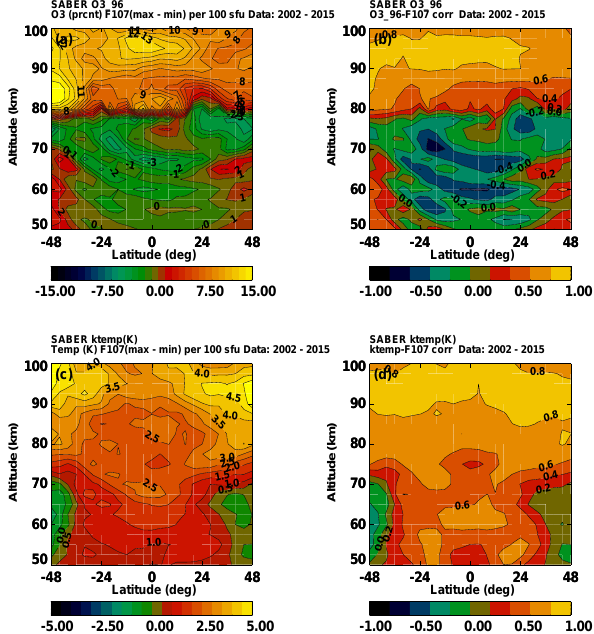
Figure 3. Ozone and temperature responses to solar variability on altitude (50 to 100km) vs. latitude (48 ◦ S to 48 ◦ N) coordinates. Top row left: ozone responses at solar max − ozone responses at solar min, %(100sfu) − 1 . Right panel: correlation coefficients between ozone zonal means and 10.7cm flux. Bottom row: as in top row but for temperature (K). Brown–green borders denote zero contours, with brown areas denoting positive